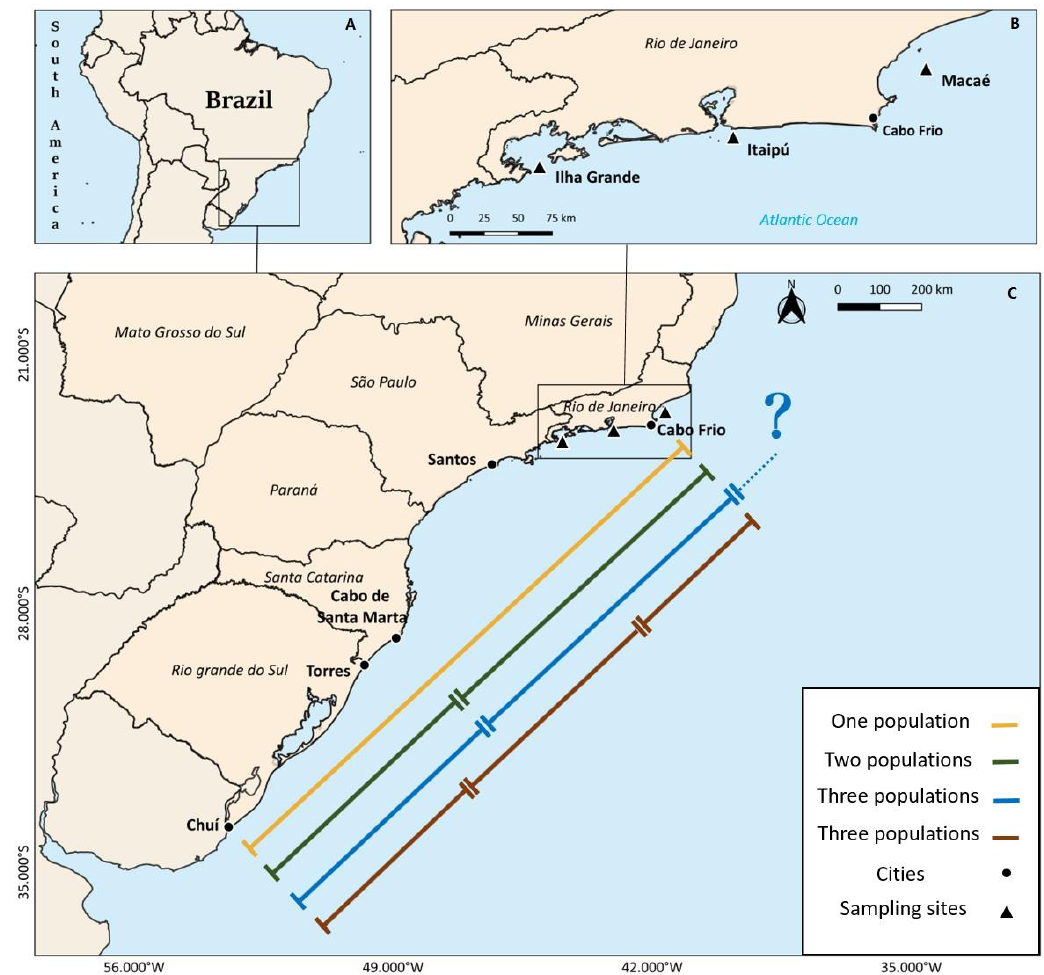
Figure 1. Map of southeastern-south Brazilian coast, indicating the different population units of Figure 1. Location of Brazil in South America ( A ), and the southeastern-south Brazilian coast ( B ), Micropogonias furnieri previously described (for further information, see Introduction). In the upper indicating the different population units of Micropogonias furnieri previously described (for further right corner, the map of the coast of the State of Rio de Janeiro, Brazil, is presented showing the information, see Introduction). In the upper right corner ( C ), the map of the coast of the State of Rio three areas sampled in this study (black triangles): Macaé (North), Itaipú (Center) and Ilha Grande de Janeiro, Brazil, is presented showing the three areas sampled in this study (black triangles): Maca é (South). (North), Itaip ú (Center) and Ilha Grande